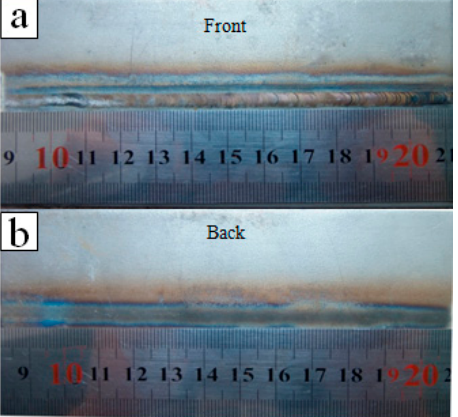
Figure 1. The argon tungsten ‐ arc weld joint of 443 stainless steel.